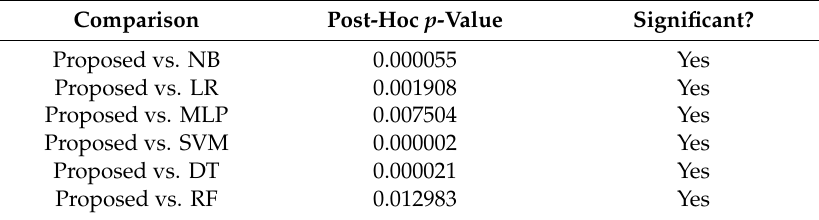
Table 10. Comparative results of all models using the Holm-based Friedman post-hoc test. Comparison